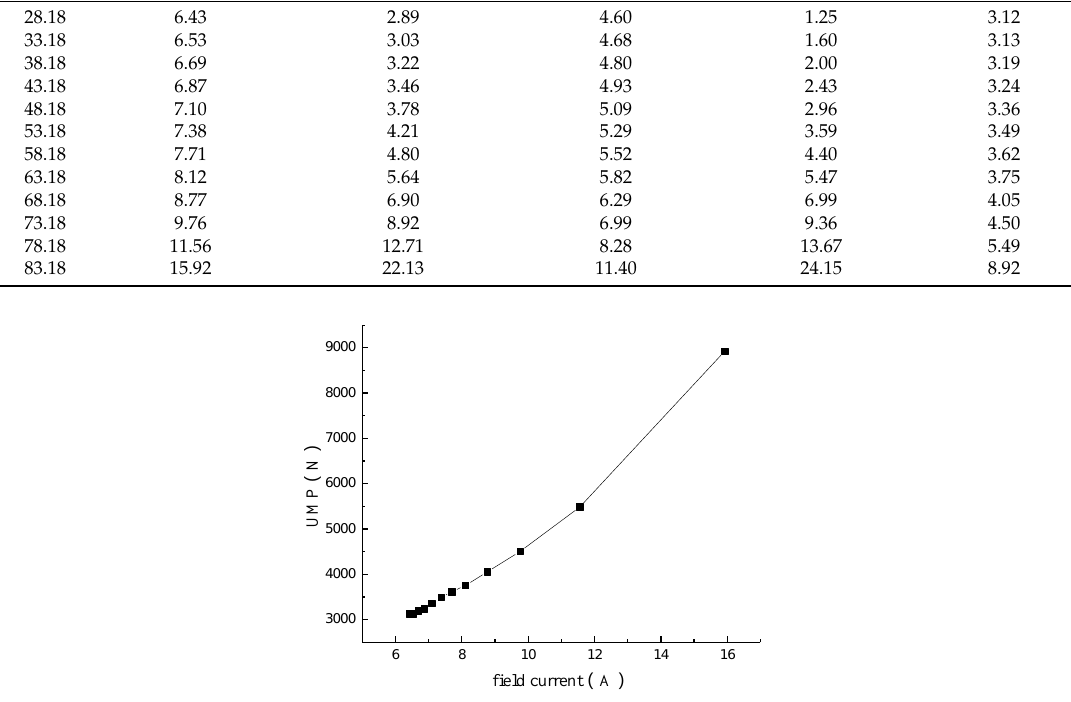
Table 8. Operation data of A1552 model machine field winding on taps 2–4 short circuit.